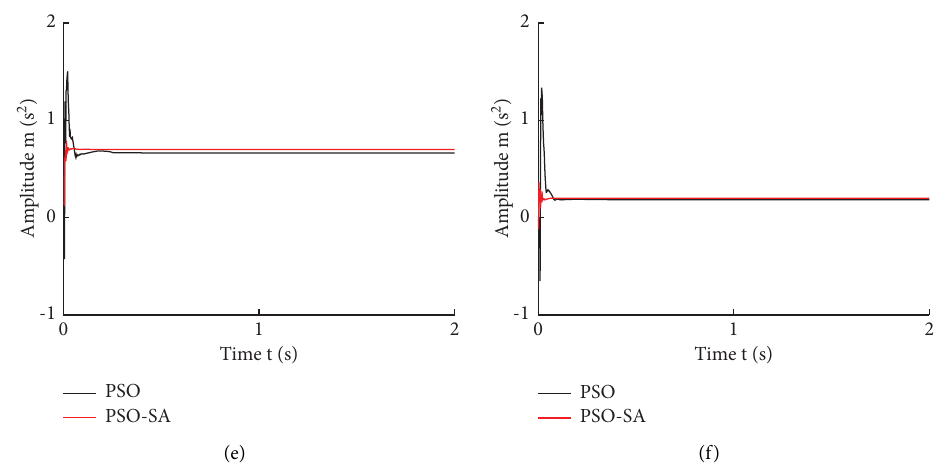
Figure 5: Amplitude curves of each degree detected based on PSO-SA and PSO algorithm: (a) fundamental wave, (b) second harmonic, (c) third harmonic, (d) fourth harmonic, (e) ffth harmonic, and (f) sixth